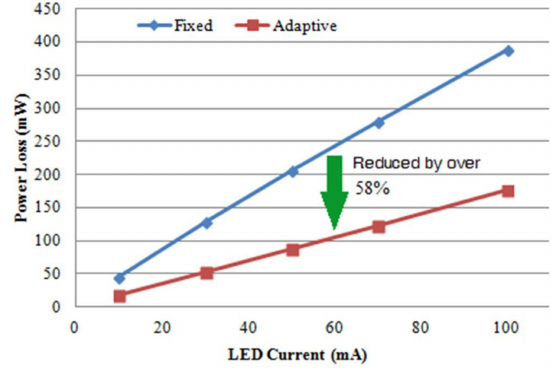
Figure 16. Power loss comparison with and without ADVE